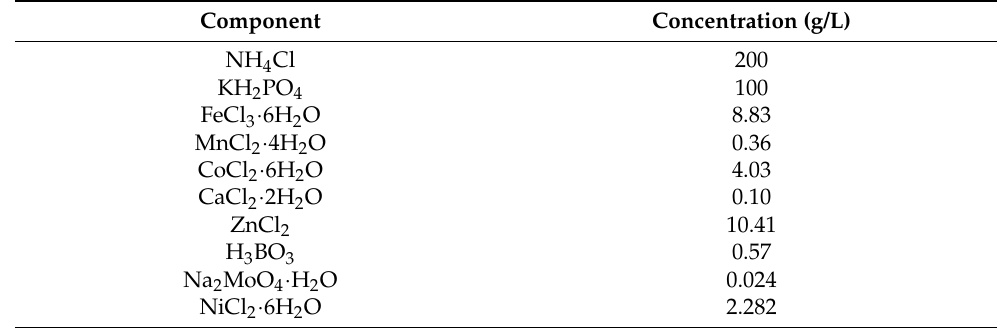
Table 2. Nutrient-containing solution used as supplement for digestion of fourth-range products (fruit and vegetable